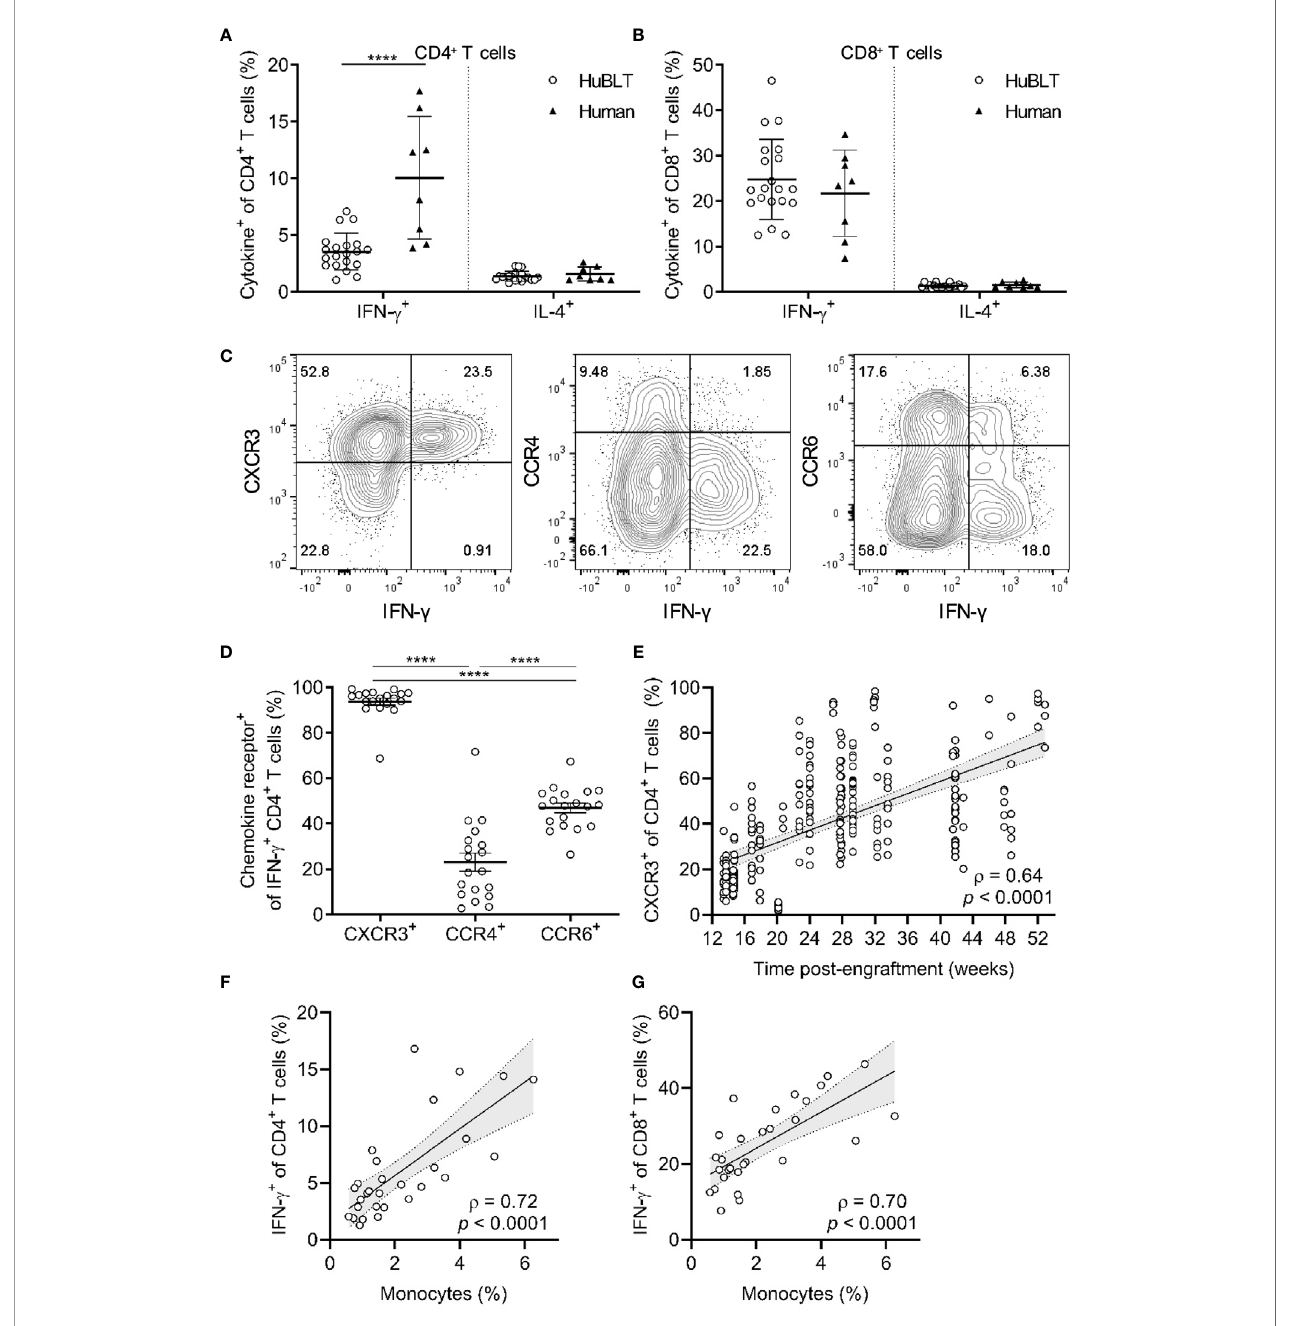
FIGURE 5 | T H 1 polarization in HuBLT mice is impaired but improves with innate immune reconstitution and age. (A, B) Peripheral blood leukocytes from HuBLT mice ( n = 20 from 1 human donor tissue; empty circles) and healthy adult human donors ( n = 8, black triangles) were stimulated with PMA and ionomycin and assessed via fl ow cytometry for expression of IFN- g and IL-4 in CD4 + T cells (in A ) and CD8 + T cells (in B ). (C, D) PMA- and ionomycin-stimulated CD4 + T cells from the peripheral blood of HuBLT mice were assed for IFN- g production and expression of the indicated chemokine receptors (CXCR3, CCR4, and CCR6). Representative fl ow plots (in C ) and aggregate data (in D , n = 19 mice from 6 distinct human tissue donors) are presented. (E) Peripheral blood CD4 + T cells from HuBLT mice ( n = 282 mice from 18 distinct human tissue donors) were analyzed for CXCR3 expression as a surrogate marker for T H 1 polarization at different times post-engraftment. (F, G) Monocyte frequencies (percent of CD14 + cells of all hCD45 + cells) were correlated to PMA- and ionomycin-stimulated IFN- g expression in CD4 + T cells (in F ) and CD8 + T cells (in G ) in HuBLT mice ( n = 29 mice from 2 distinct human tissue donors >12 weeks post-engraftment). For (A , B , D) , lines with error bars depict mean and standard deviation, and **** denotes p < 0.0001 after performing a Wilcoxon signed rank test. For (E – G) , linear regression (black line) with 95% con fi dence intervals (gray shade) are depicted for visualization, as well as Spearman coef fi cients ( r ) with corresponding p